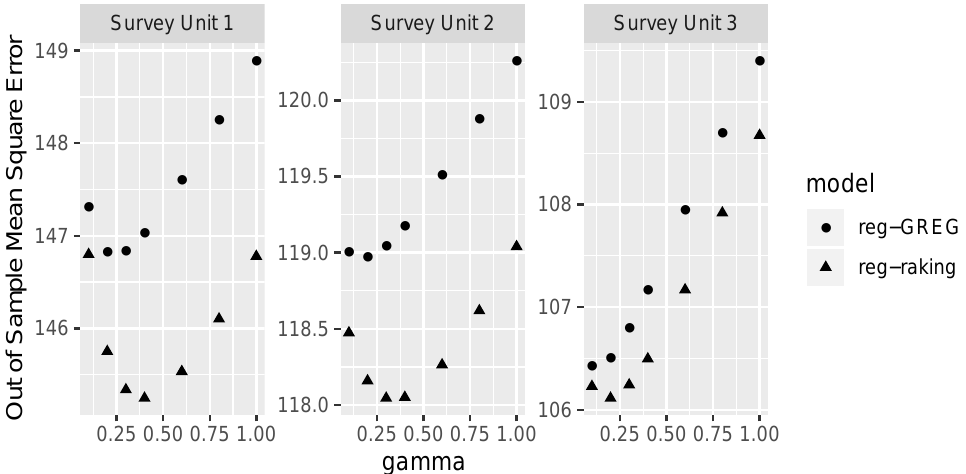
Figure 3. Cross-validation error as a function of the regularization parameter γ for regularized raking (triangle) and ridge GREG (circle), for survey units 1 ( left ), 2, and 3 ( right ). The response variable is the mean square error for predicting forest volume at out-of-sample